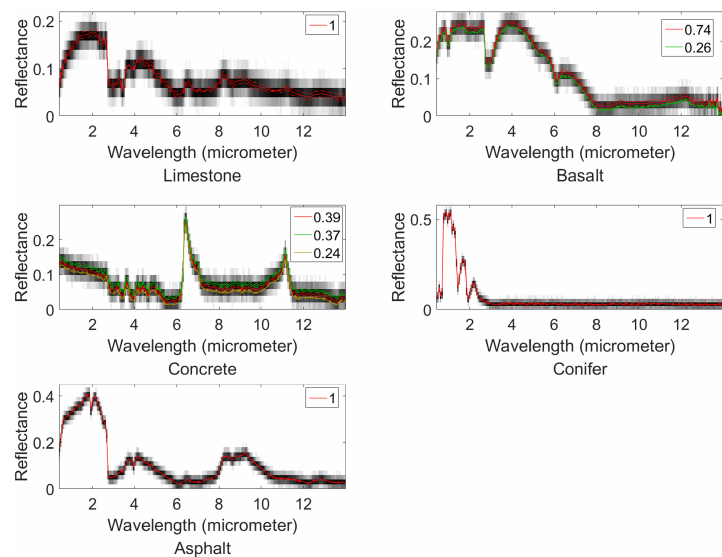
Figure 3. Estimated GMM-SS-LRR in the wavelength–reflectance space for the synthetic dataset. The background gray image represents the histogram created by placing the pure pixel spectra into the reflectance bins at each wavelength. The different colors represent different components, where the solid curve is the center µ jk , the dashed curves are µ jk ± 2 σ jk v jk ( σ jk is the square root of the large eigenvalue of Σ jk while v jk is the corresponding eigenvector), and the legend shows the prior probabilities.